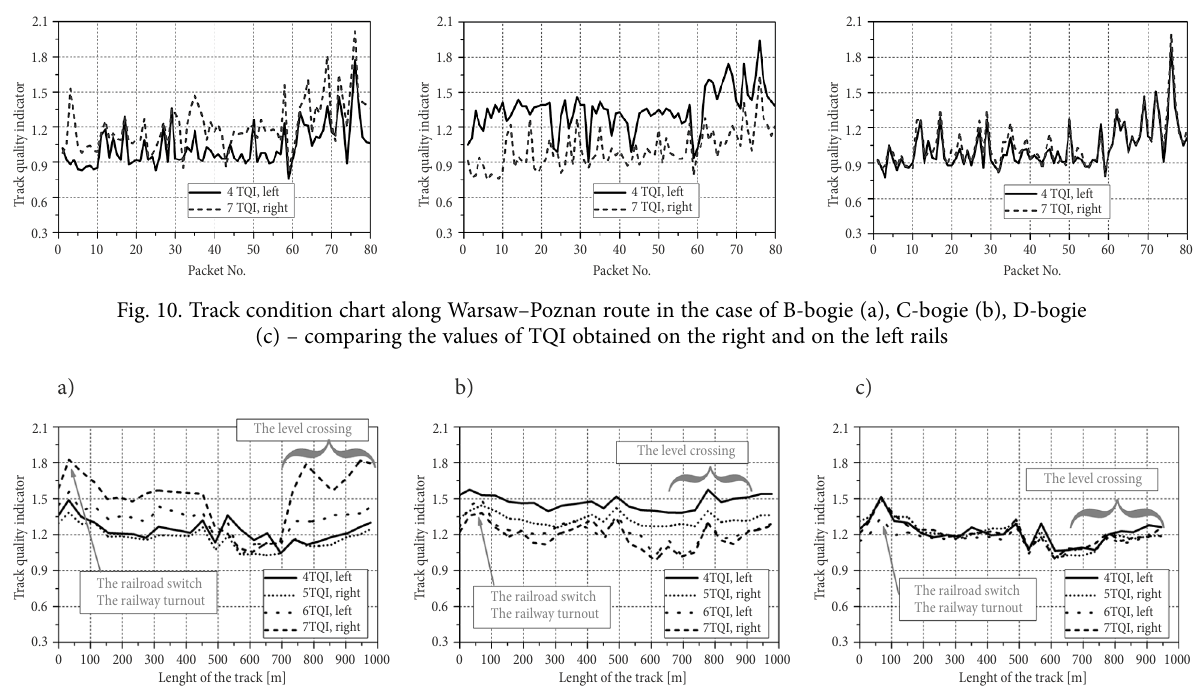
Fig. 11. Track condition chart for1 km track section near Sochaczew, as recorded on 25 January 2012 in the case of B-bogie (a), C-bogie (b), D-bogie (c) – comparison of the values of TQI obtained on the right and on the left